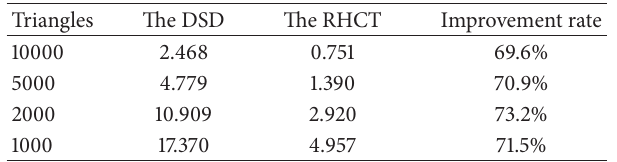
Table 3: RMS error comparison for simplifying elephant animation model (unit: 10 − 3